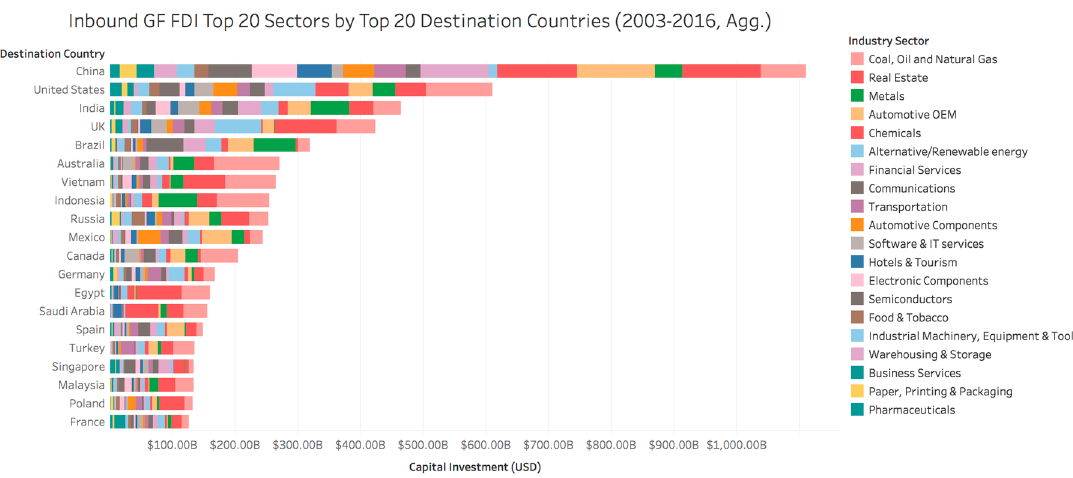
Figure 6. Sectors of Greenfield FDI investments in the top 20 countries across 2003–2016. Real estate is a dominant investment followed by energy.